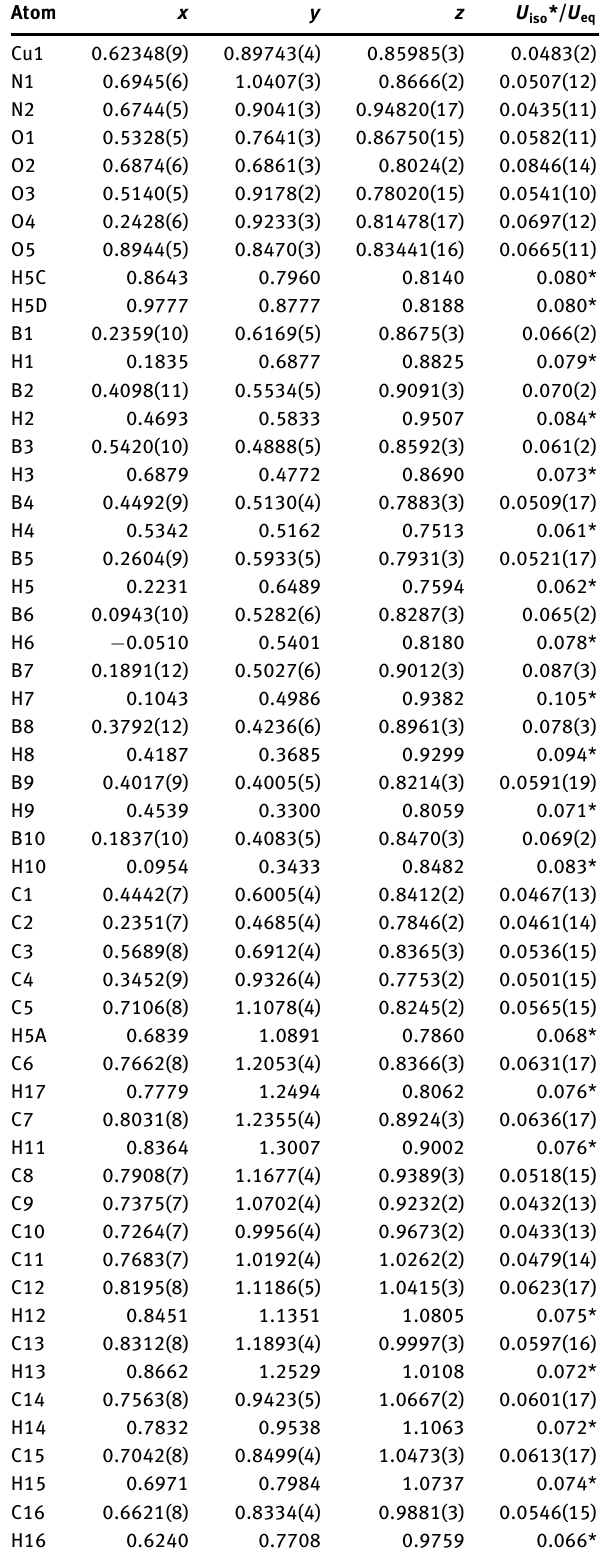
Table 2: Fractional atomic coordinates and isotropic or equivalent isotropic displacement parameters (Å 2